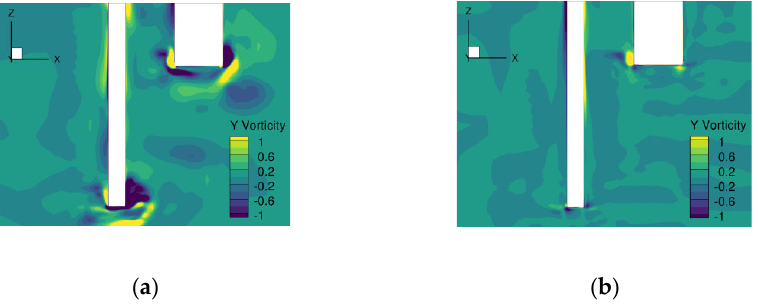
Figure 16. Snapshot of the y-vorticity field in the symmetry plane for two different wave frequencies, in case of Configuration 1; ( a ) vorticity field at the wave frequency where a resonant behavior of the piston mode is predicted ( ω = 0.75 rad/s); ( b ) vorticity field at the wave frequency where a resonant behavior of the pitch sloshing mode is predicted ( ω = 1.1 rad/s).